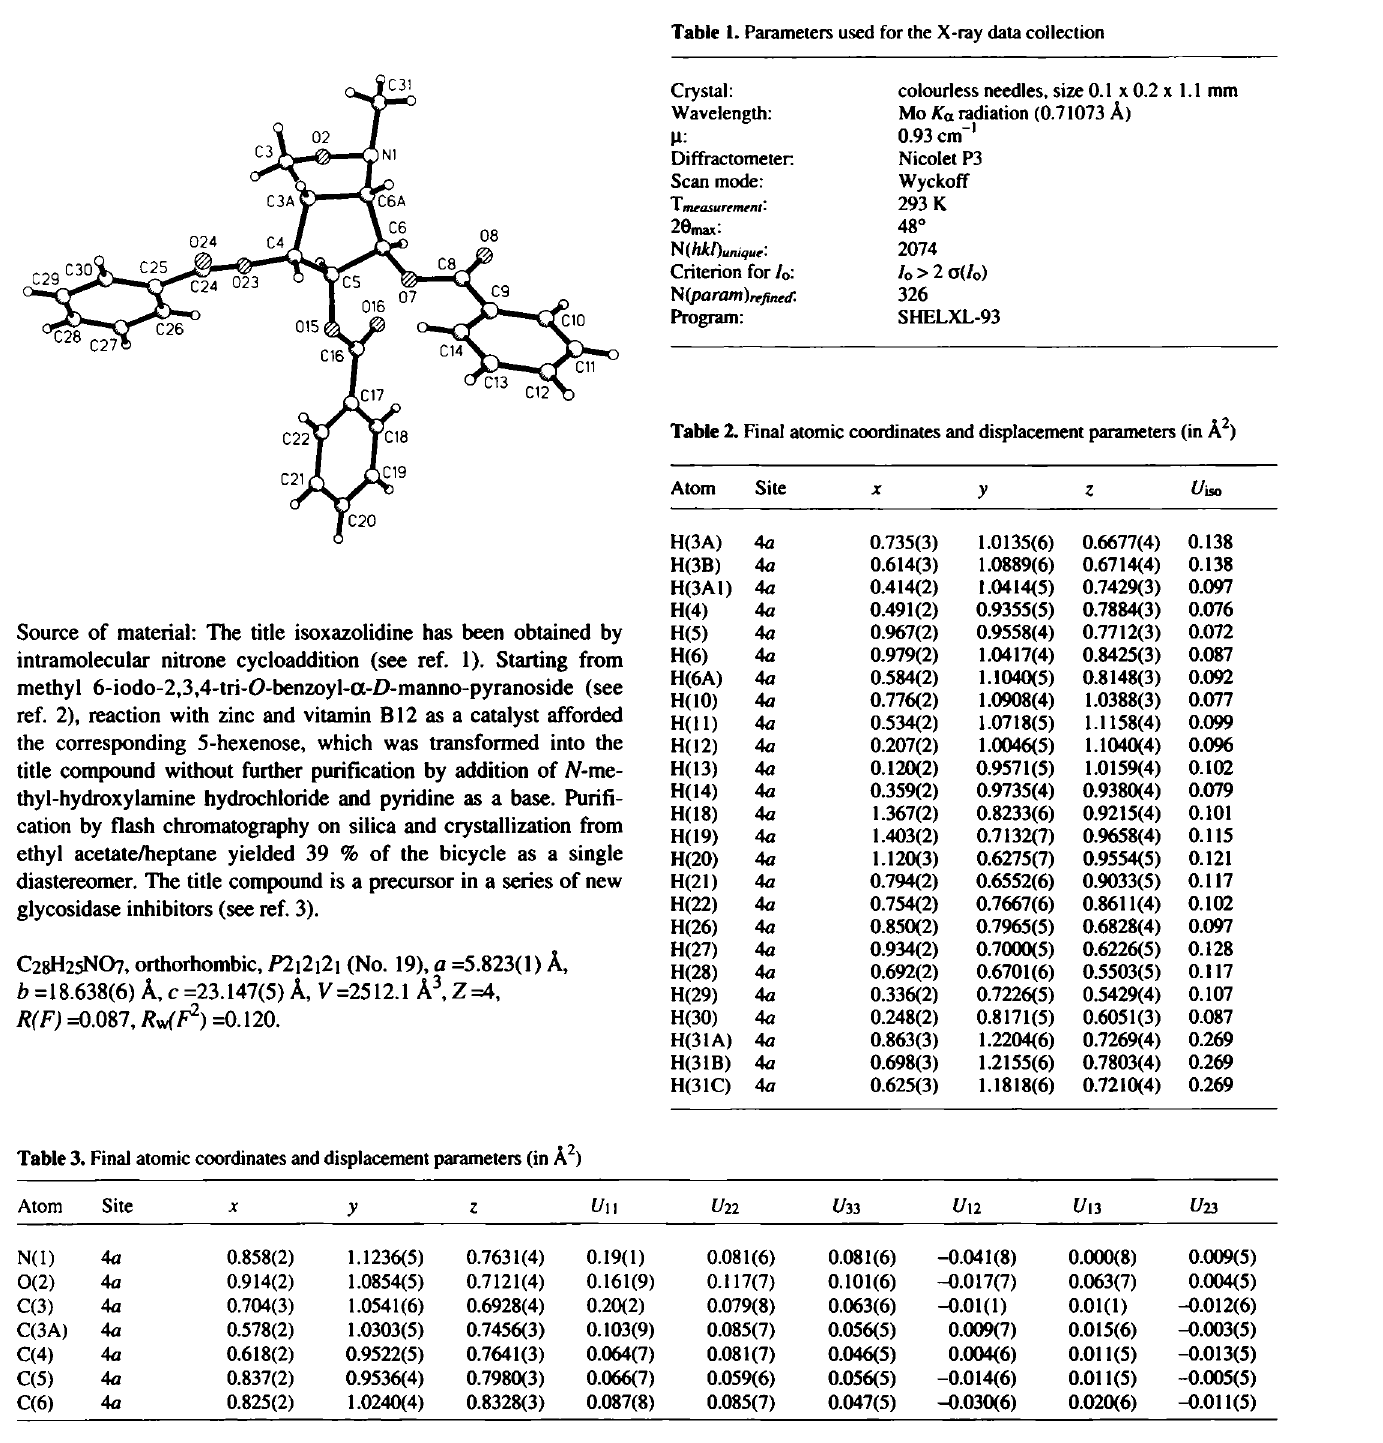
Table 1. Parameters used for the X-ray data collection